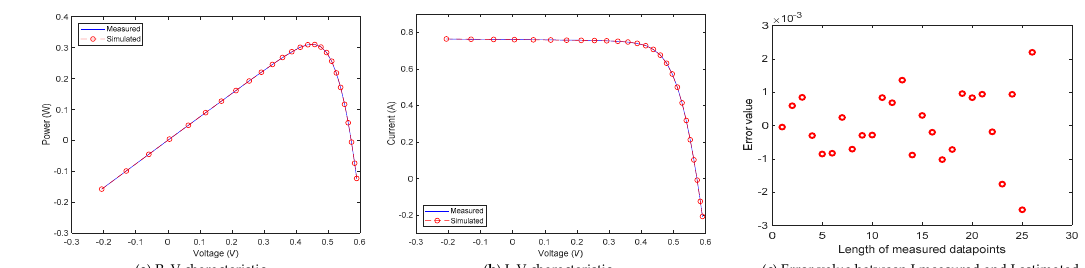
Figure 8. Comparison between the measured and estimated data extracted using MJSO on DDM for R.T.C France.